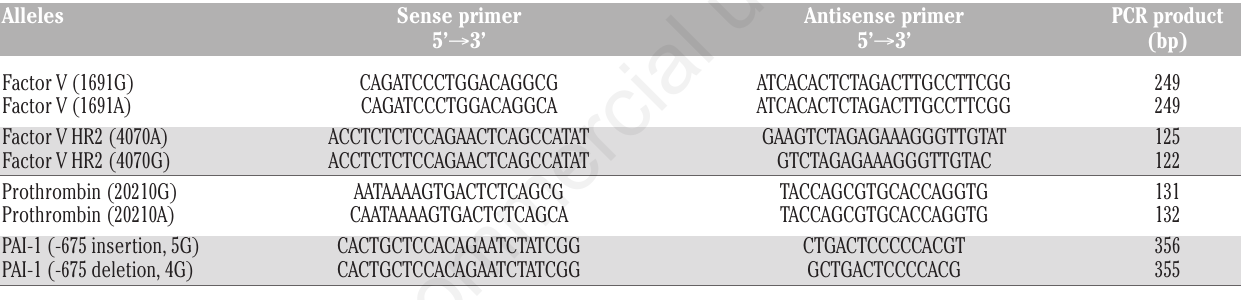
Table 1. Nucleotide sequence of primers used for genotype screening by amplification refractory mutation system-polymerase chain reaction method. Alleles